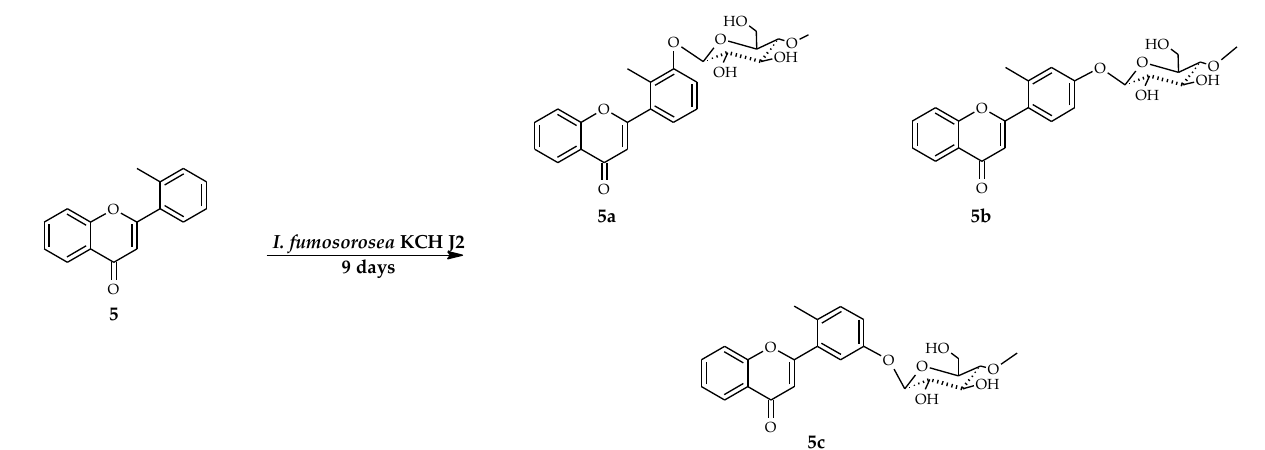
OHOOHO O Scheme 9. Microbial transformation of 2 (cid:48) -methylflavone ( 5 ) in the I. fumosorosea KCH J2 culture. Scheme 9. Microbial transformation of 2′ -methylflavone ( 5 ) in the I. fumosorosea KCH J2 culture. Table 3. 1 H-NMR chemical shifts δ (ppm) and coupling constants J (Hz) of 2 (cid:48) -methylflavone ( 5 ) (Supplementary Materials: Figure S122). Glycosylation occurring at C-3 ′ was confirmed and products of its biotransformations 5a – 5c in Acetone-d6, 600 MHz (Supplementary Materials: in the HMBC experiment by coupling of the proton at the anomeric carbon atom (δ = 5.00 Figures S106, S120, S136, OHOOH Scheme 10. Key COSY (on the left) and HMBC (on the right) correlations for the structure elucidation of product 5a .